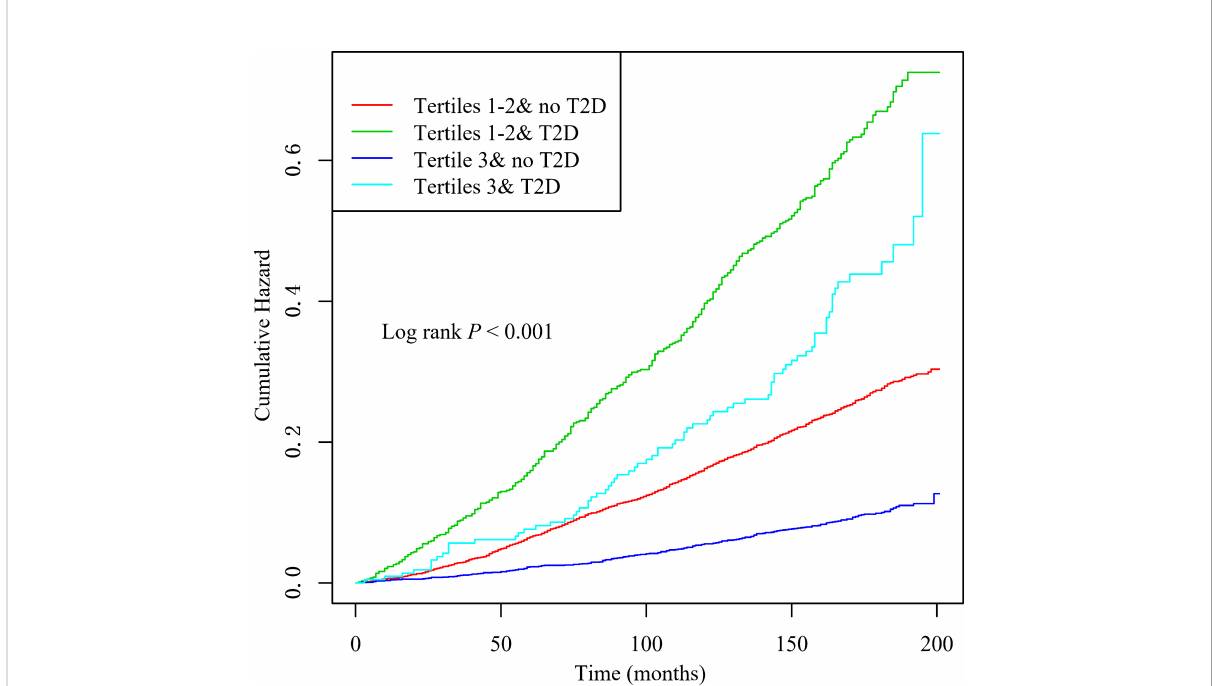
FIGURE 2 Kaplan – Meier curves of cumulative hazards of all-cause death by baseline leukocyte telomere length (T1 – T2 vs T3) and type 2 diabetes status (with,